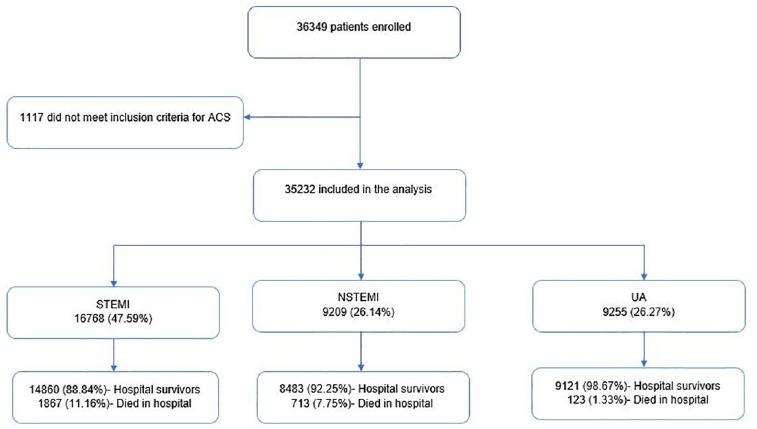
Fig 1. NCVD-ACS registry flowchart, 2012–2016. NSTEMI, non-ST-segment elevation myocardial infarction; STEMI, ST-segment elevation myocardial infarction; UA, unstable angina.